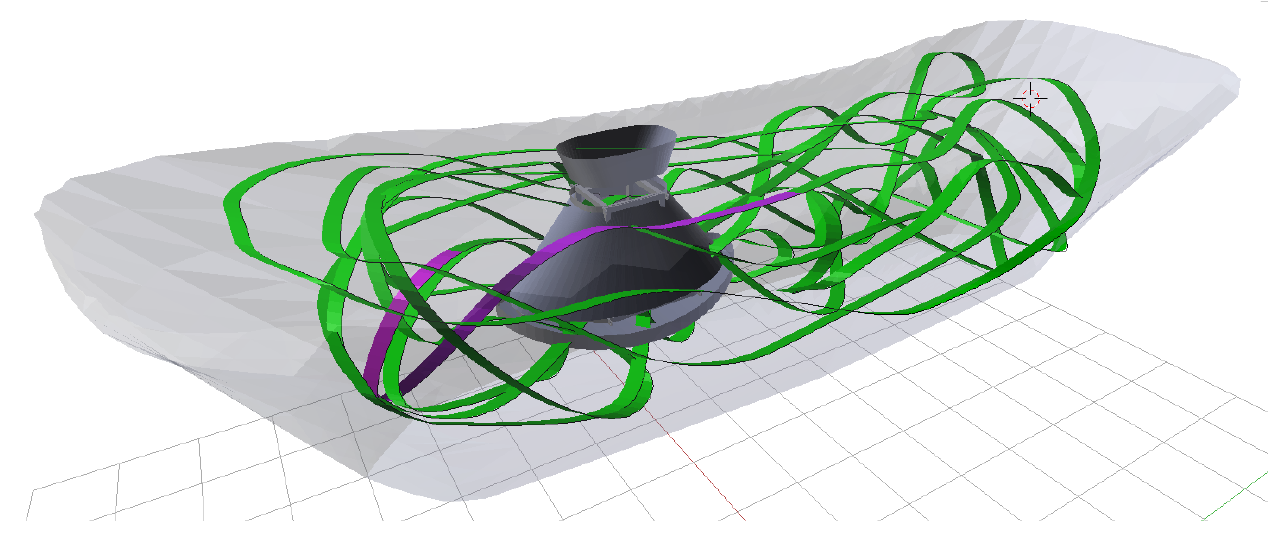
Figure 4. Planned trajectory for a cable robot with visualization of the path verification results and workspace (green, path segment feasible; violet, not